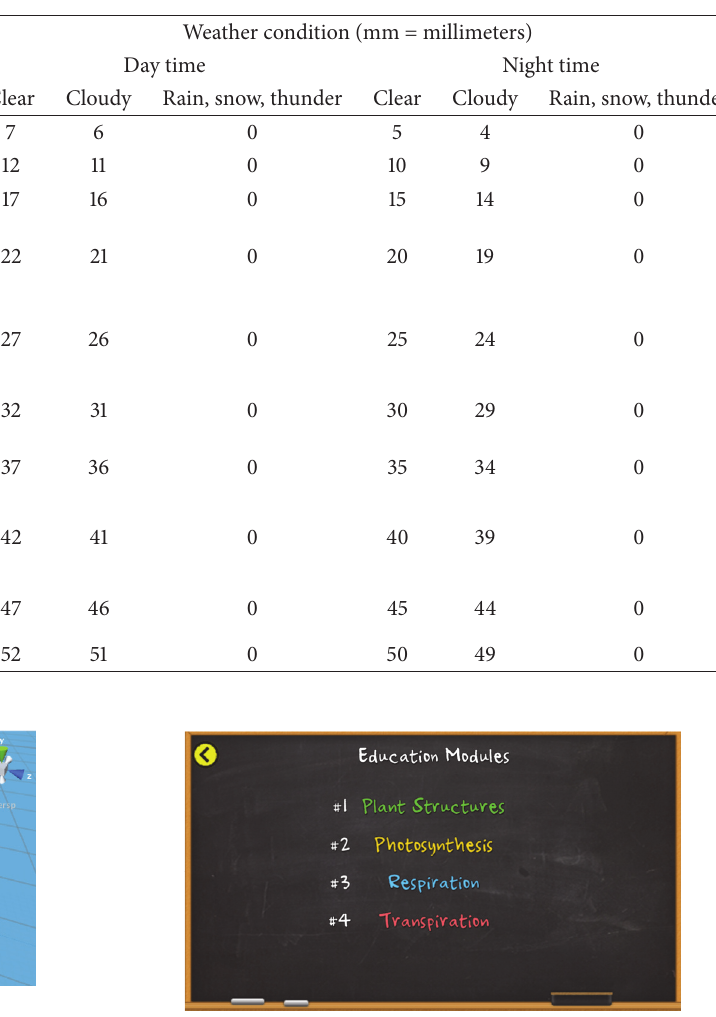
Figure 21: Content of education modules